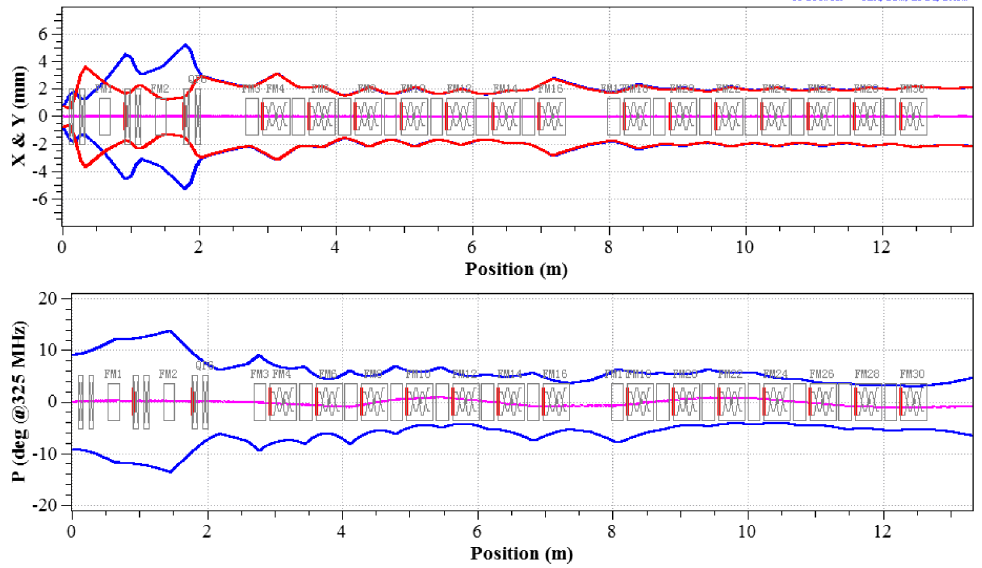
FIG. 24. The envelope evolution of the superconducting section of Injector I together with MEBT with 100% input emittance deviation (increasing in all three directions).